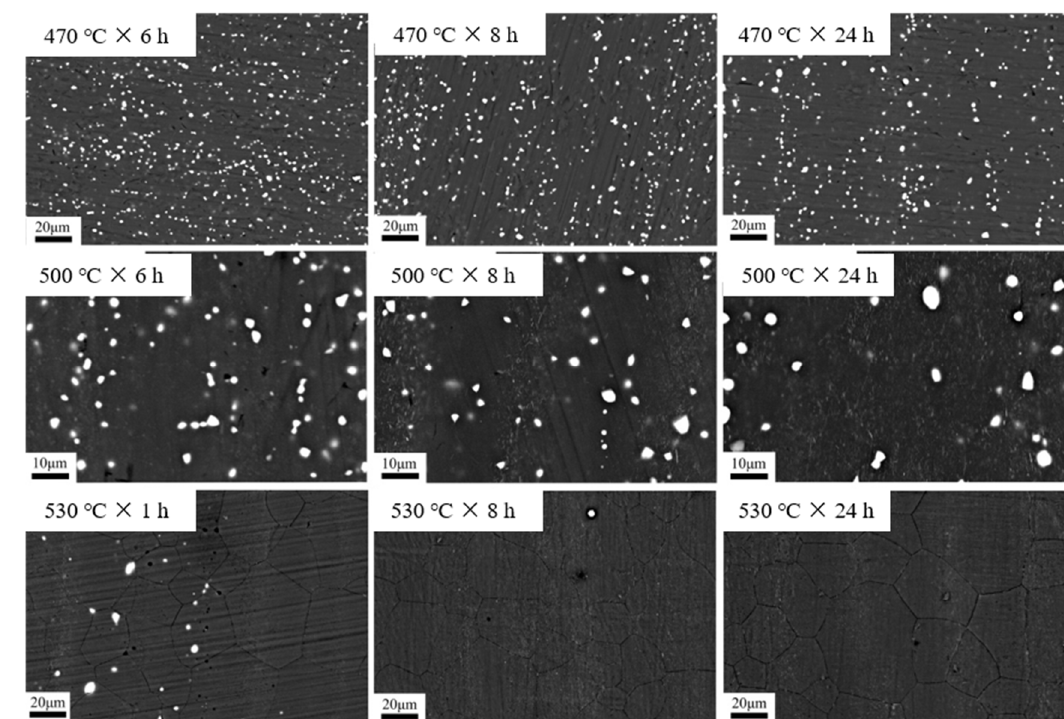
8 of 16 Figure 5. The curves of average grain size versus holding time pieces at ( a ) 470 °C, ( b ) 500 °C, and ( c ) 530 °C. 3.3. Dependence of Phase Content on Heat Treatment Regime As mentioned in the above analysis, the presence of the second phase will hinder the grain growth. For this reason, the BSE photographs of different heat treatment states were obtained using SEM. After that, the second phase, and its volume fraction in each state, were observed and counted in combination with the image processing software, and the results are shown in Figures 6 and 7. As seen, the volume fraction of the second phase inside the alloy gradually decreases with the increase in temperature and the extension of holding time. Moreover, by comparing the BSE photographs for a given soaking time, it is clear that the second phase is more sensitive to temperature. For example, the volume fraction of the second phase decreased to 6.32%, 2.97%, and 0.1% after holding at 470 °C,